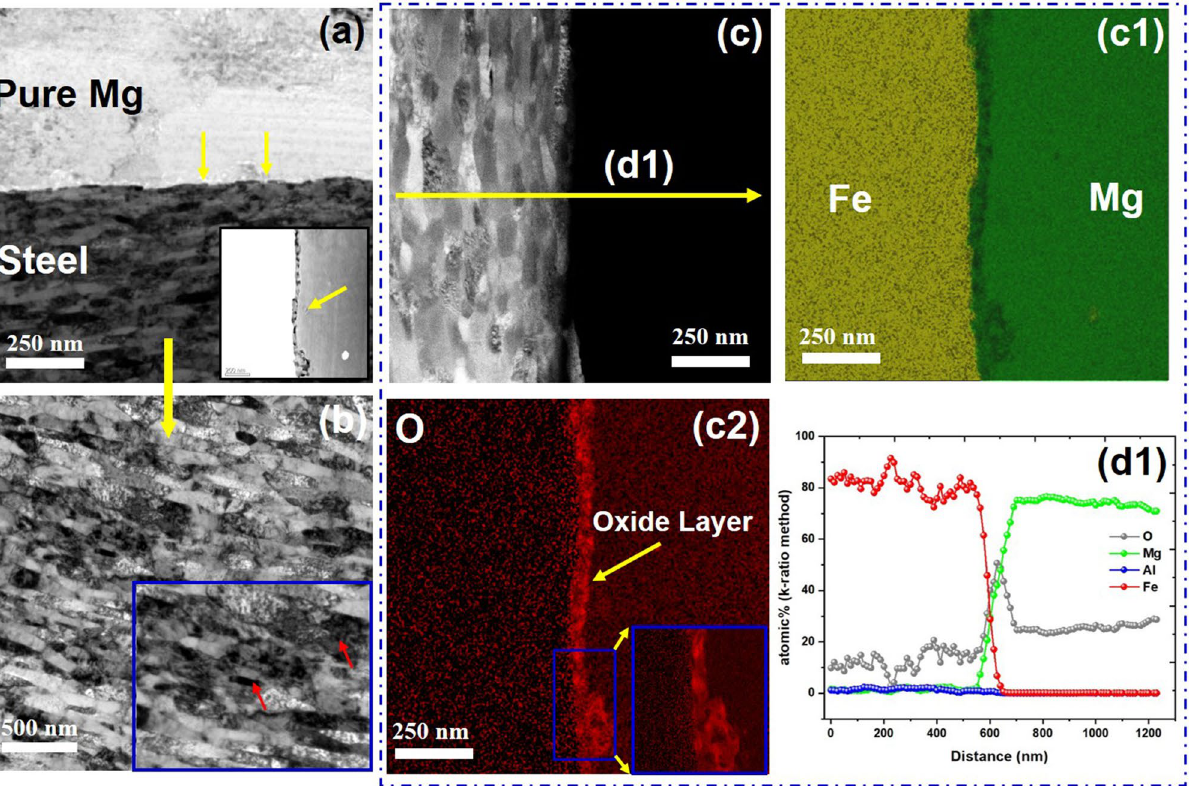
Figure 3. TEM with EDS of pure Mg-DP 590 joint. ( a ) Joint interface (inset: high-contrast, high-angle annular dark field image with oxide layer at the interface); ( b ) nanosized steel grains (inset: dislocations, marked by red arrows), ( c ) S/TEM image with location of EDS line scan; EDS mapping of (c1) Fe and Mg, (c2) O (inset: high magnification view), (d1) line scan elemental analysis plot for pure Mg-DP